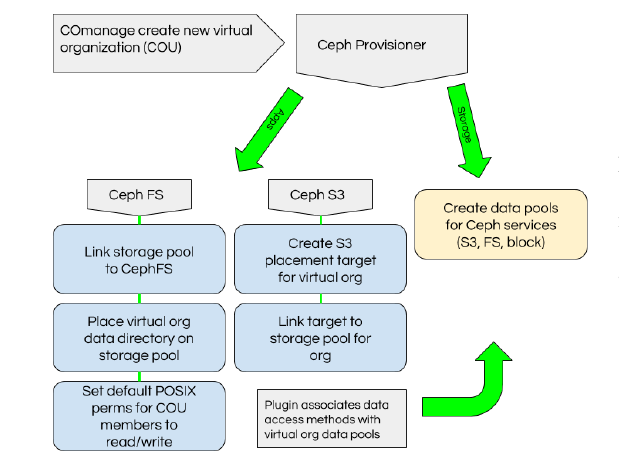
Figure 2. COmanage provisioning steps for Ceph VO storage include new pools for CephFS, S3, Rados, and steps to link those pools to directories or S3 placement